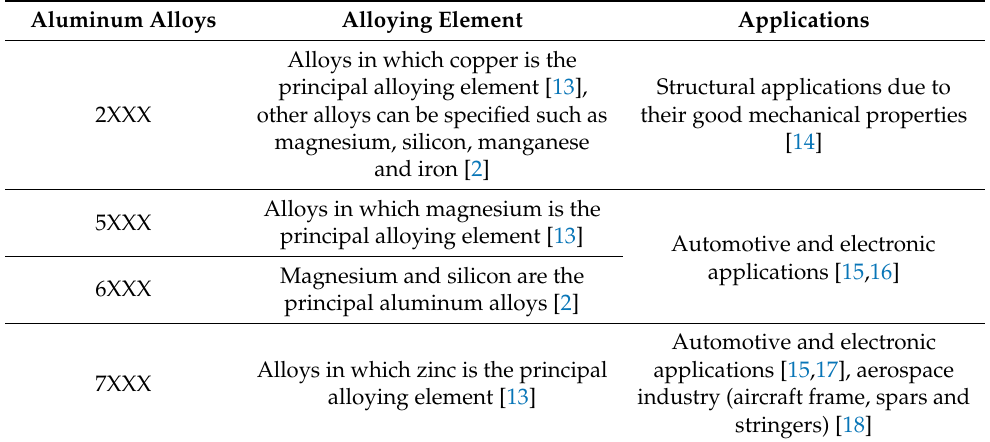
Figure 2. Types of pins. Table 1. Aluminum